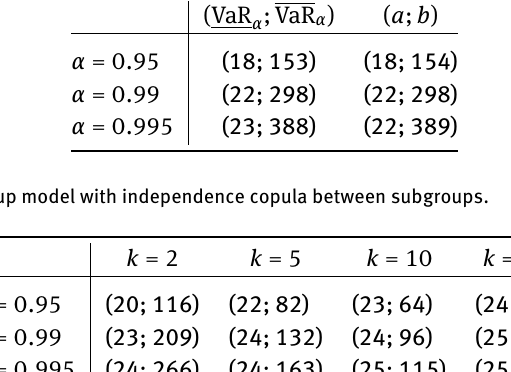
Table 5.1: Unconstrained VaR bounds (VaR α , VaR α ) calculated by RA, case without subgroups.